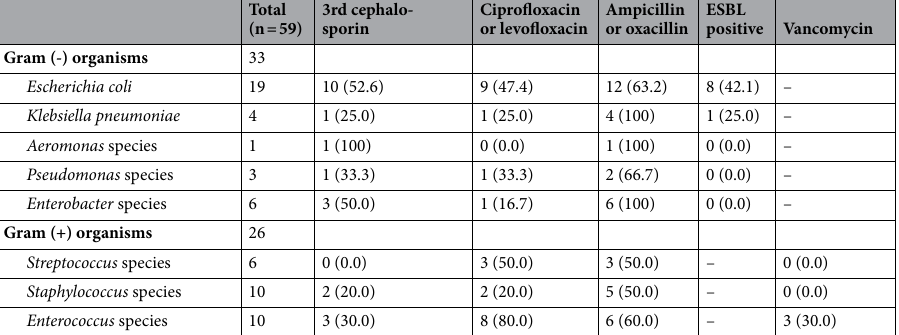
Table 2. Profiles of isolated microorganisms and antibiotic resistance in patients with spontaneous bacterial peritonitis. Data were expressed as number (percentage). *Extended spectrum β-lactamase.